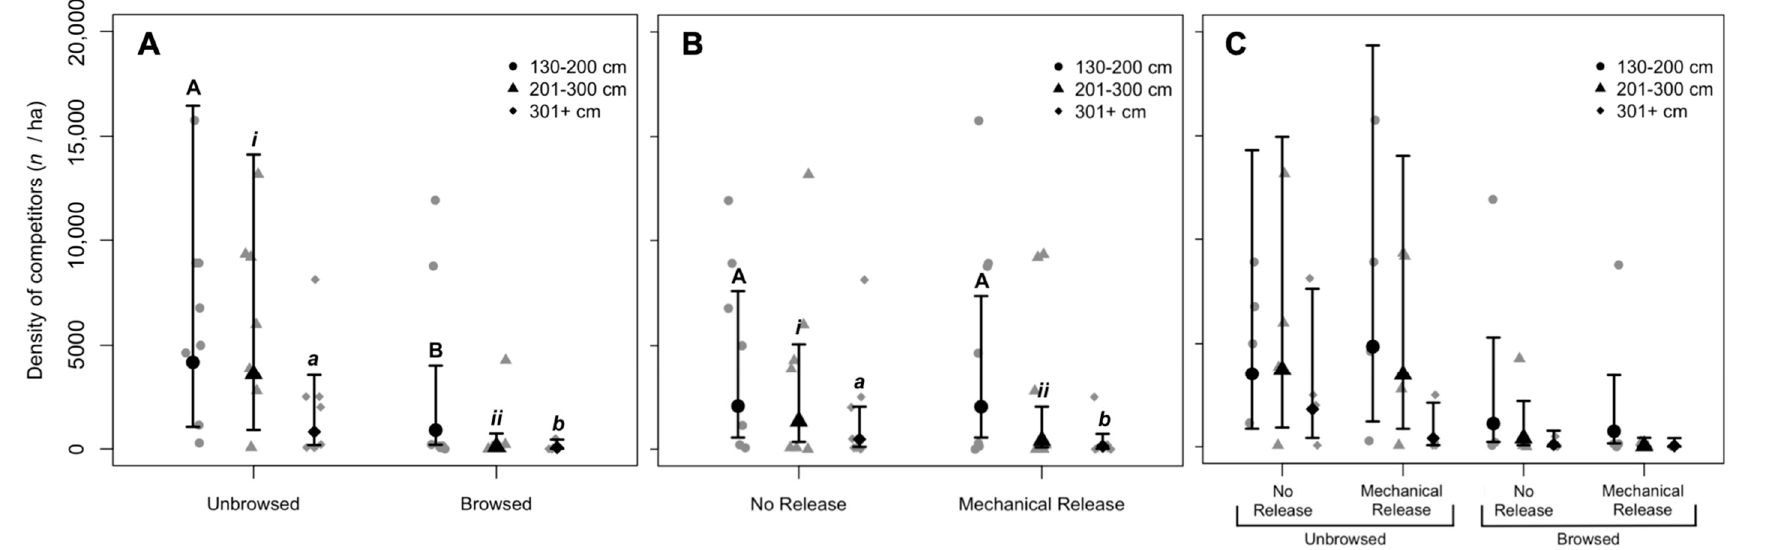
Figure 2. Density of the competing tree saplings per height class in four white spruce plantations receiving combinations of ( A ) browsing exclusion (unbrowsed or browsed) and ( B ) forest cleaning (no release or mechanical release) treatments. The non-significant interaction between browsing exclusion, forest cleaning, and height is shown in ( C ) to visually compare the e ff ect size of all the treatments. Predicted values were estimated from a generalized linear mixed model with a negative binomial distribution and with the forest cleaning treatment nested within the browsing exclusion treatment, nested within the site, as a random factor. Error bars are 95% confidence intervals. Raw averages are shown in gray. In ( A , B ), contrasts between the treatments levels were made within each height class: caps letters represent contrast results for the 130–200 cm class, i and ii for the 201–300 cm class, and lowercase letters for the > 301 cm class. Di ff erent letters / symbols represent significant e ff ects of treatment on the density of the height class at p = 0.1. See Table 1 for statistical contrast results.